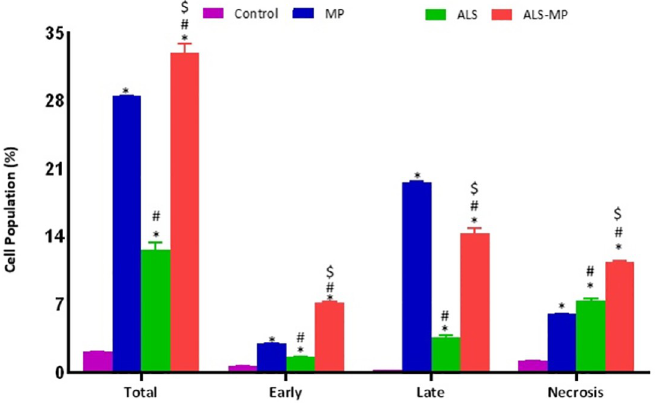
Fig 6. Determination of cellular mortality after Annexin V staining by flow cytometry. � Significantly different from control p < 0.05, #significantly different from MP p < 0.05, $sig-nificantly different from ALS-Raw p < 0.05.